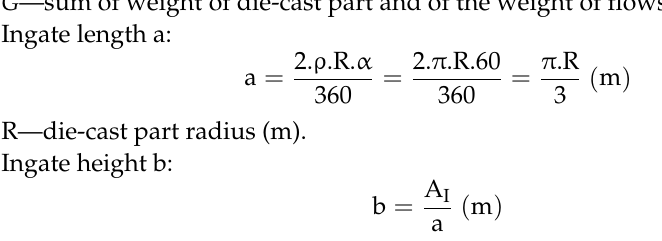
Figure 1. Scheme of attachment of the ingate to the cylindrical area ingate area AI.